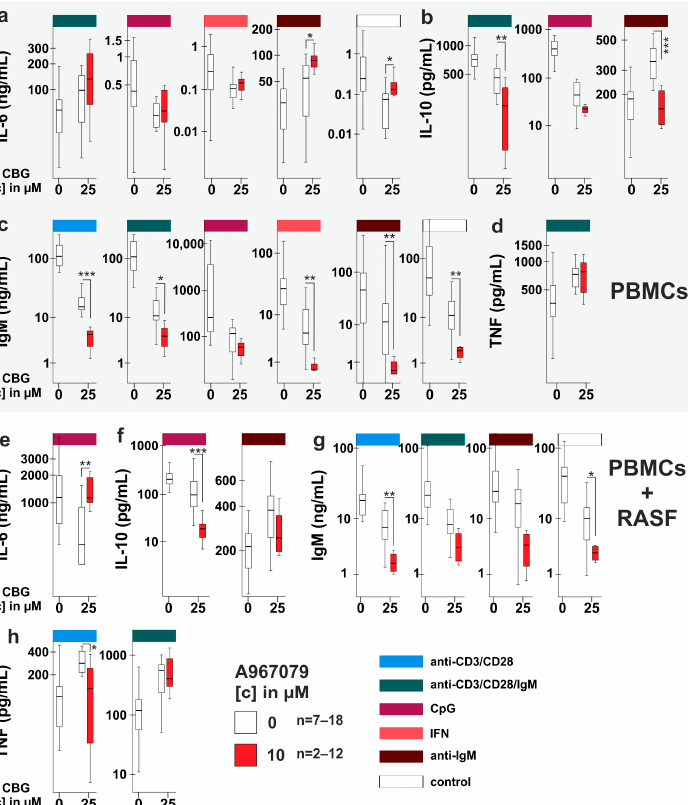
Figure 5. TRPA1 involvement in cytokine and antibody production modulated by CBG in PBMCs and PBMC/RASF co-cultures. ( a – h ) PBMCs alone ( a – d ) or PBMC/RASF co-cultures ( e – h ) were